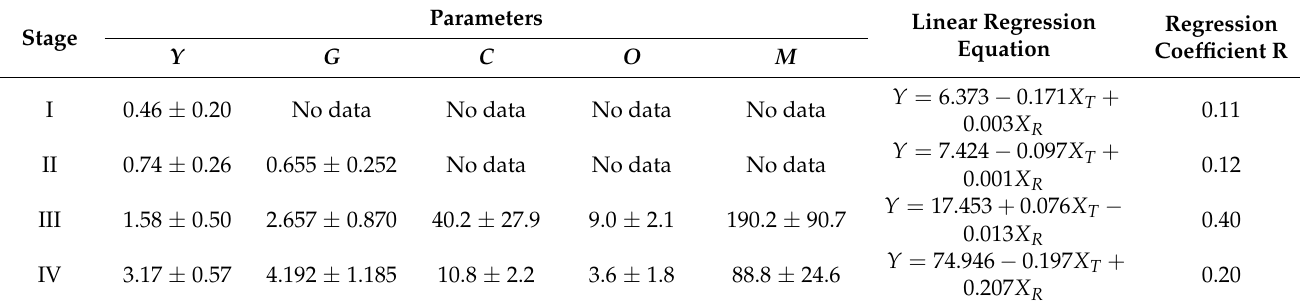
Parameters Linear Regression